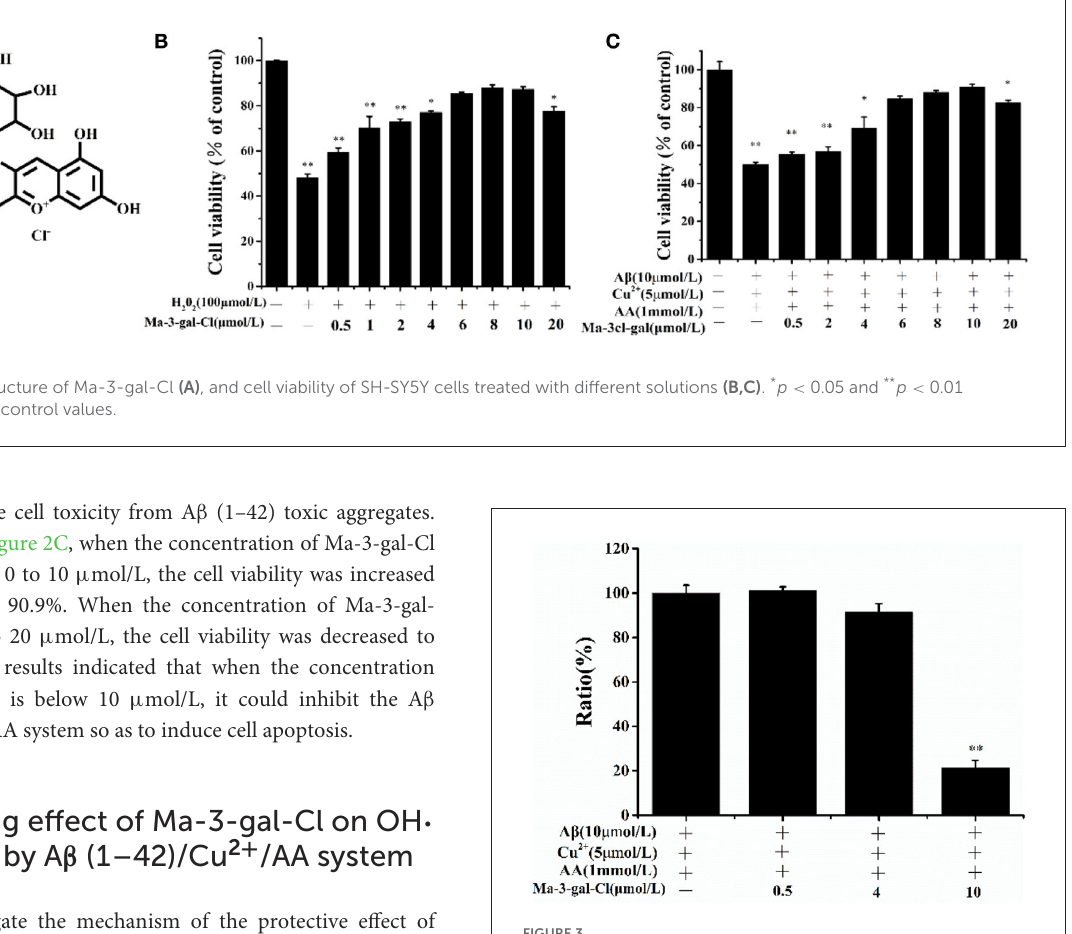
FIGURE3 CCA fluorescence ratio of A β (1–42)/Cu 2 + /AA solutions in the absence or presence of different concentrations